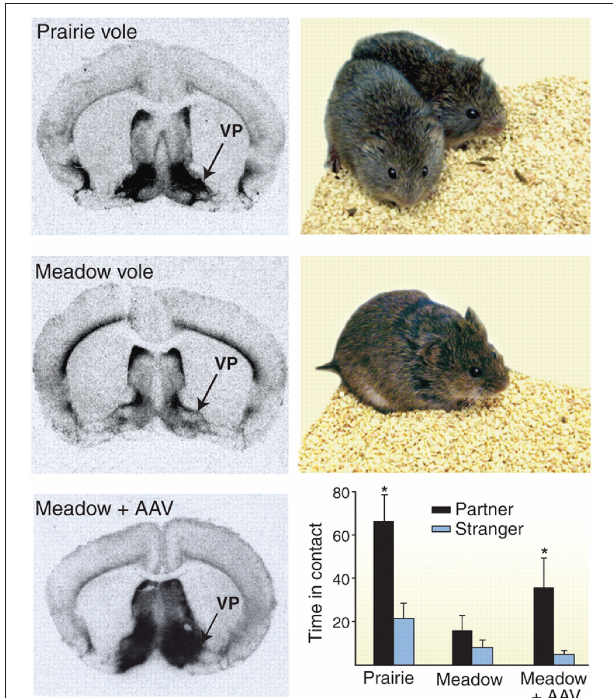
FIGURE 1 | Example of receptor autoradiography study in voles showing higher density of vasopressin receptor 1a staining in monogamous prairie voles (top) as compared to polygamous meadow voles (middle). When receptor expression was increased using an adeno associated viral (AAV) vector, polygamous meadow voles demonstrated more preferential contact with their partners (bottom). Figure reproduced with permission from Science , (Donaldson and Young, 2008) adapted from research presented by Lim et al. (2004). ∗ p < 0.05